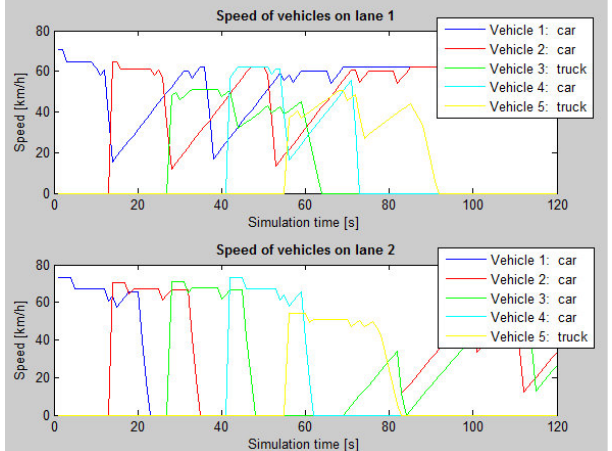
Fig. 8. Vehicle speed plots of the first five vehicles of the simulation with traffic lights in the hazardous area on the Fontanney section. We observe the two huge slow-downs in lane 1 because of the two hairpin bends. The vehicles on lane 2 are stopped by the red lights before the first hairpin